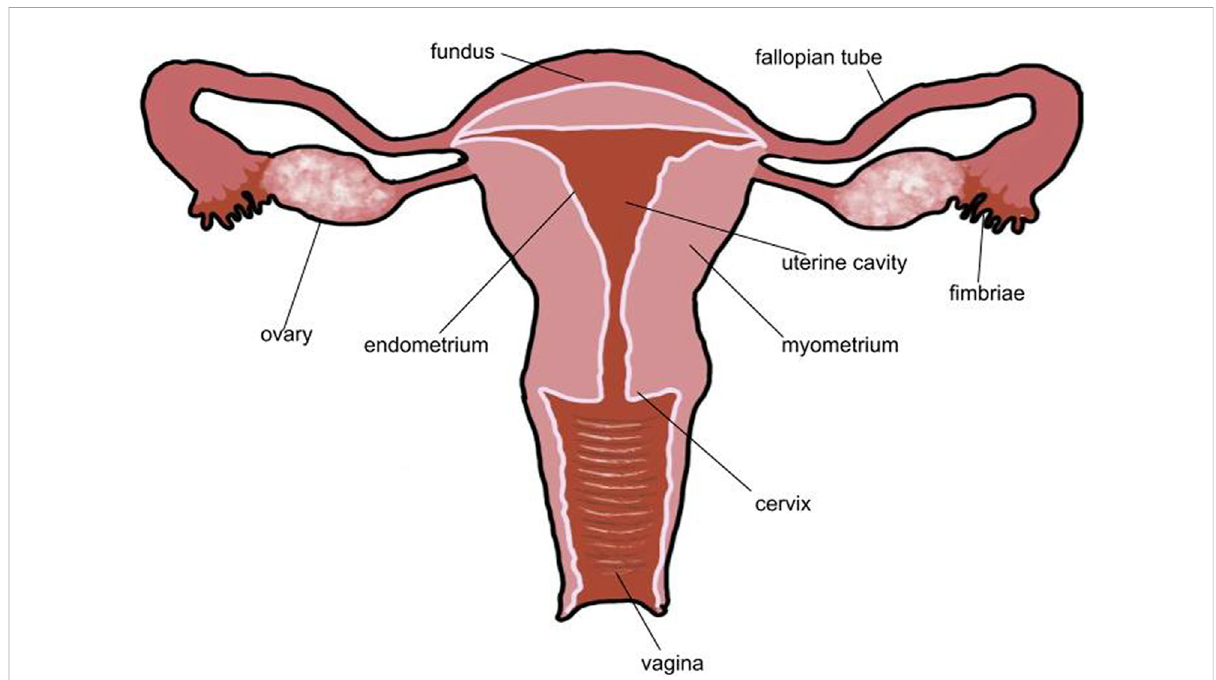
Typical healthy uterus. In a healthy uterus, there are no lesions. The endometrium is a thin layer that surrounds the uterine cavity and myometrium. Both fallopian tubes and ovaries are present. The uterine cavity is empty. No part of the uterus is distended or